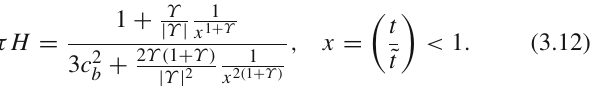
As it is clear from (3.4)–(3.9), the gravitino abundance is weakly depending on the reheating temperature T R for a range of values of the parameter Υ . Let us set